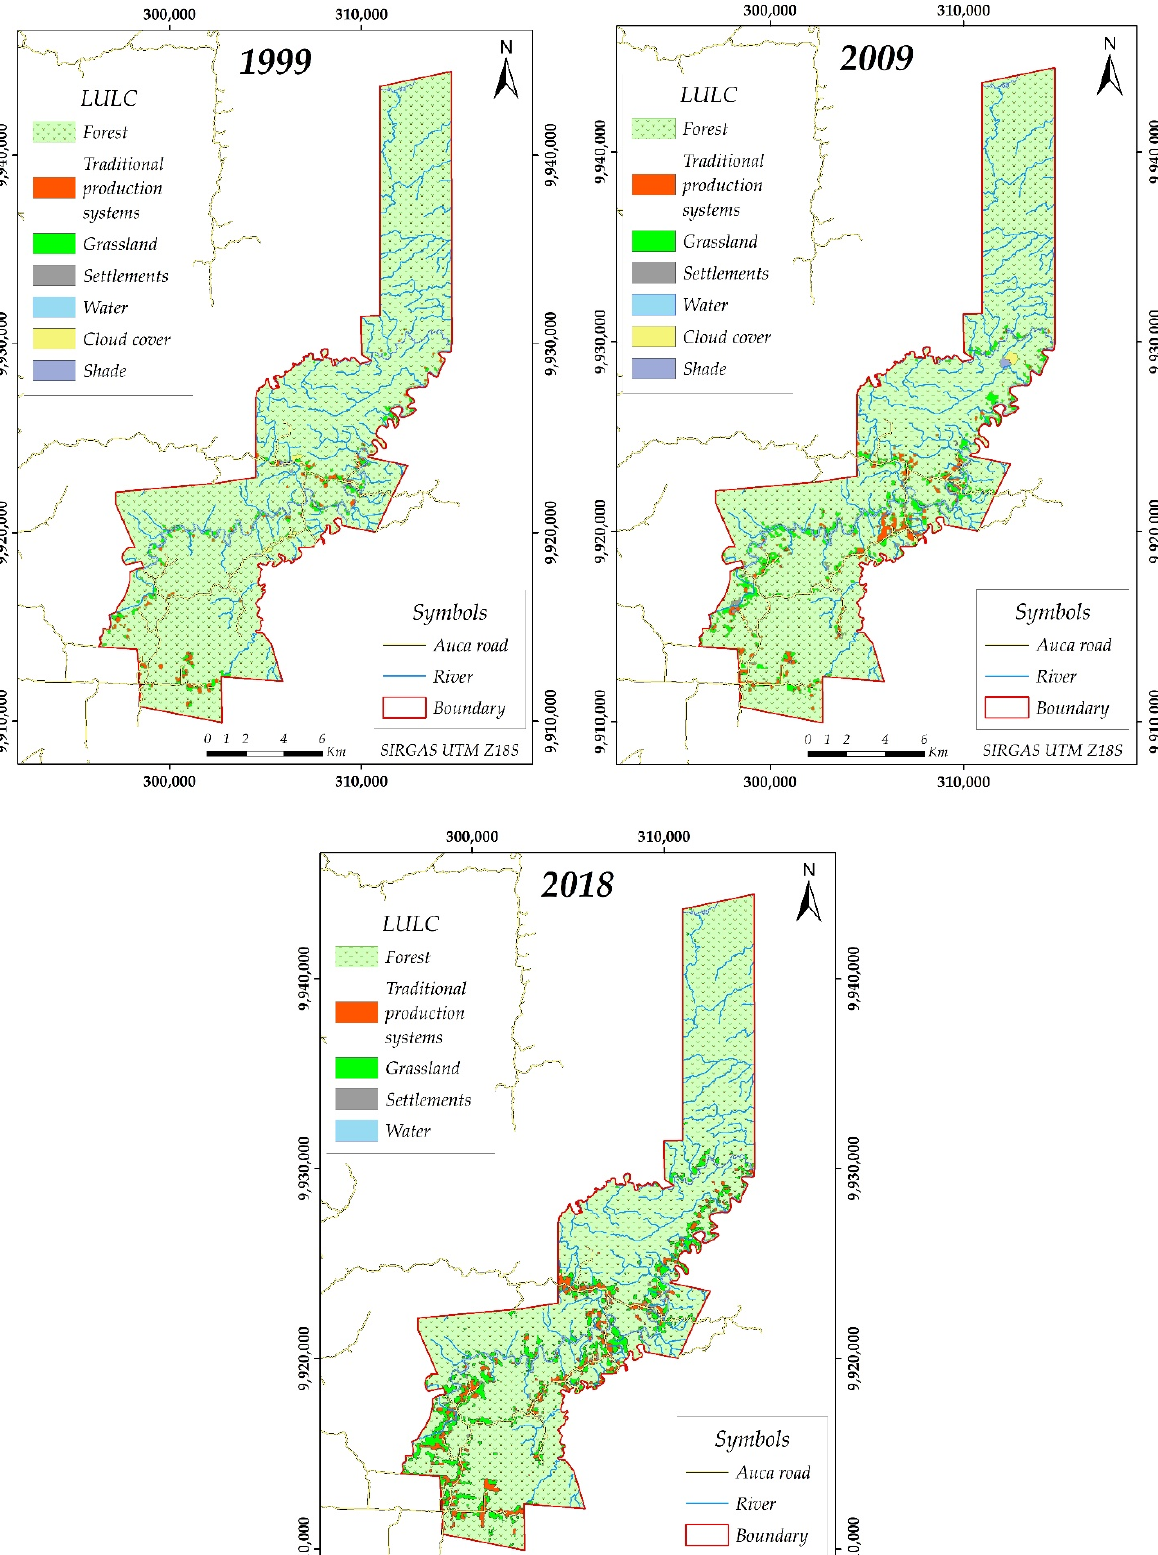
Figure 6. LULC maps for 1999, 2009, and 2018 of the DLZ’s northern zone (Dayuma and Taracoa) in the Yasuní Biosphere Reserve of the Ecuadorian Amazon Region.